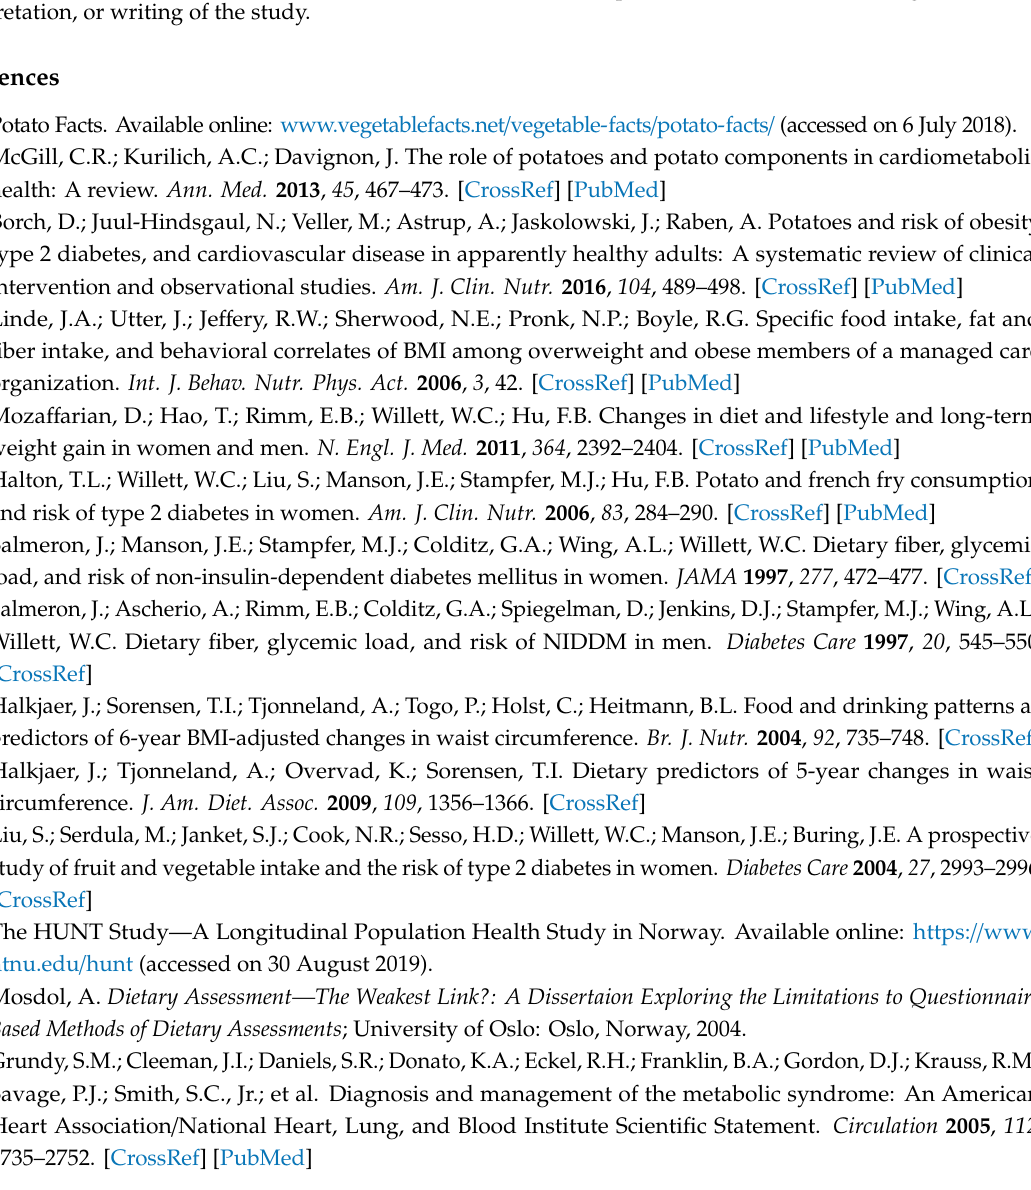
Table S1: Odds ratio (OR) for adverse levels of components of the metabolic syndrome and cardiovascular disease (CVD) risk factors according to potato consumption. Table S2: Odds ratio (OR) for adverse levels of components of the metabolic syndrome and cardiovascular disease (CVD) risk factors according to potato consumption, stratified by sex, Table S3: Odds ratio (OR) for adverse levels of components of the metabolic syndrome and cardiovascular disease (CVD) risk factors according to potato consumption, stratified by body mass